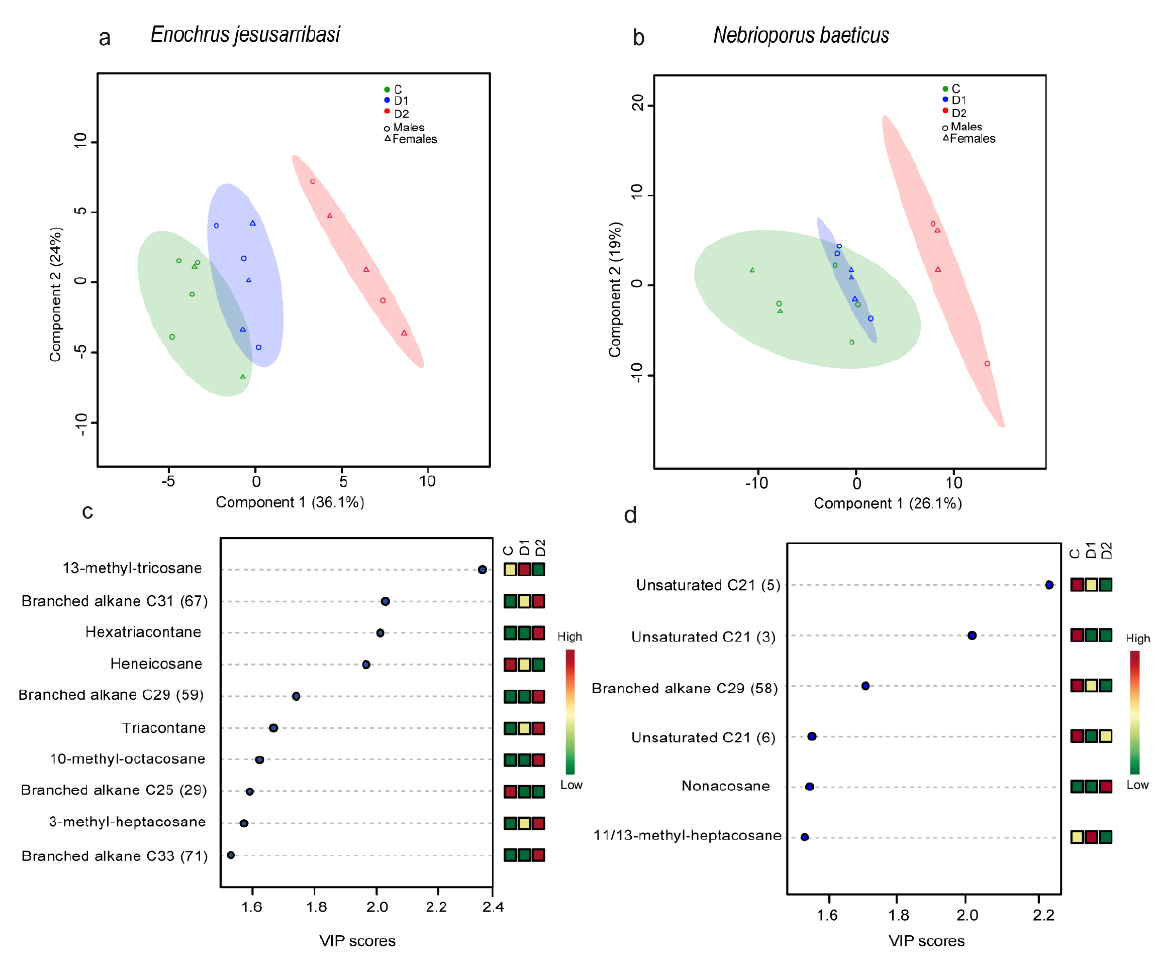
Figure 4. Score plots of the two principal components of cuticular hydrocarbons (CHC) concentration in Enochrus jesusarribasi ( a ) and Nebrioporus baeticus ( b ) (each dot represents an individual sample, ellipses represent the 95% confidence region for each species sample group, and the explained variances are shown in both axes in brackets). The variable importance plots (VIP) show the CHC compounds that contributed the most to the first axis based on their VIP scores for E. jesusarribasi ( c ) and N. baeticus ( d ) (colored squares represent the relative CHC concentrations of the corresponding compounds in each species; the corresponding ID number in Table S1 is indicated in brackets). C: water control, D1: individuals from the control exposed to desiccation, D2: individuals from the prior desiccation exposed to subsequent desiccation.